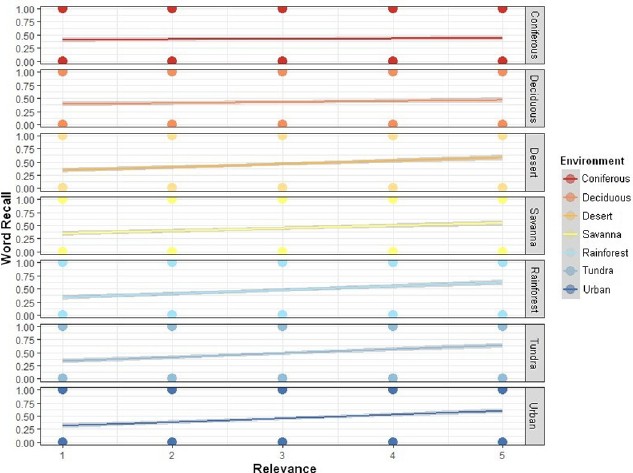
Fig 2. Relationship between the relevance + environment interaction and the recall of the participants. The colored lines represent the regression line of the relationship between the variables. The regression line inclines significantly in the desert, savanna, rainforest, tundra, and urban environments. The more relevant a word is, the more the person retrieves this information in the desert, rainforest, tundra, savanna, and urban environments.